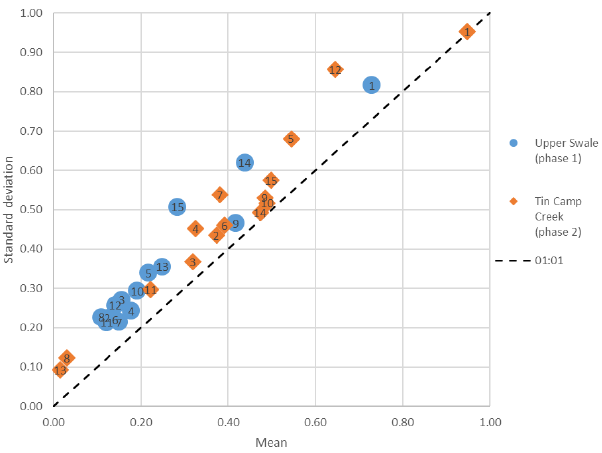
Figure 3. Aggregated scores for all elementary effects where the numbers 1–15 represent the following: 1 is the sediment